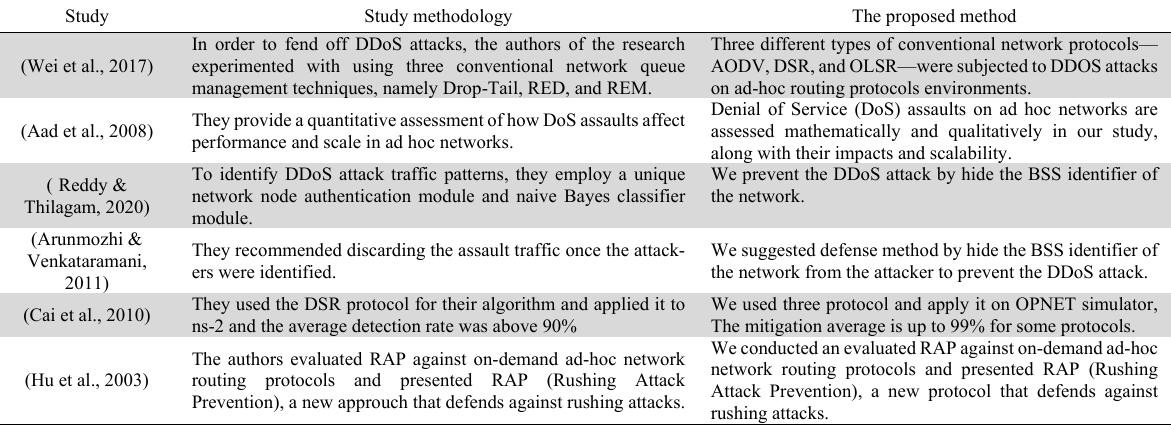
The proposed method versus other